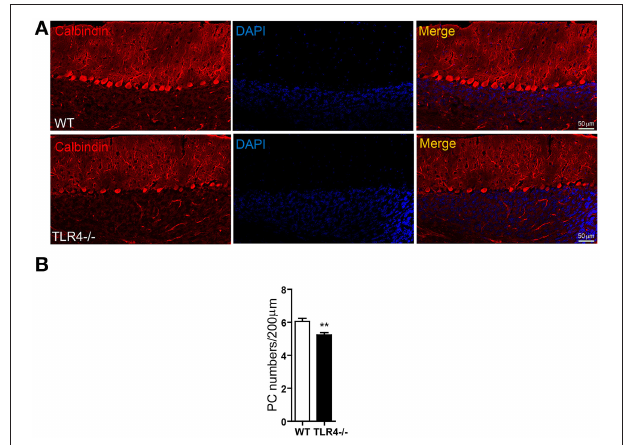
FIGURE 6 | TLR4 deficiency decreases the number of PCs in adult cerebellum. (A) PCs were identified by immunolabeling with an anti-calbindin antibody. PC somata were aligned in the PL, with their dendritic arbor spanning the whole ML. (B) Quantitative analysis of the number of calbindin-positive PCs in the PL. PC density was lower in TLR4 − / − than in WT mice. Scale bar = 50 µ m. Data was presented as mean ± SEM ( n = 5 mice/group). ** P <